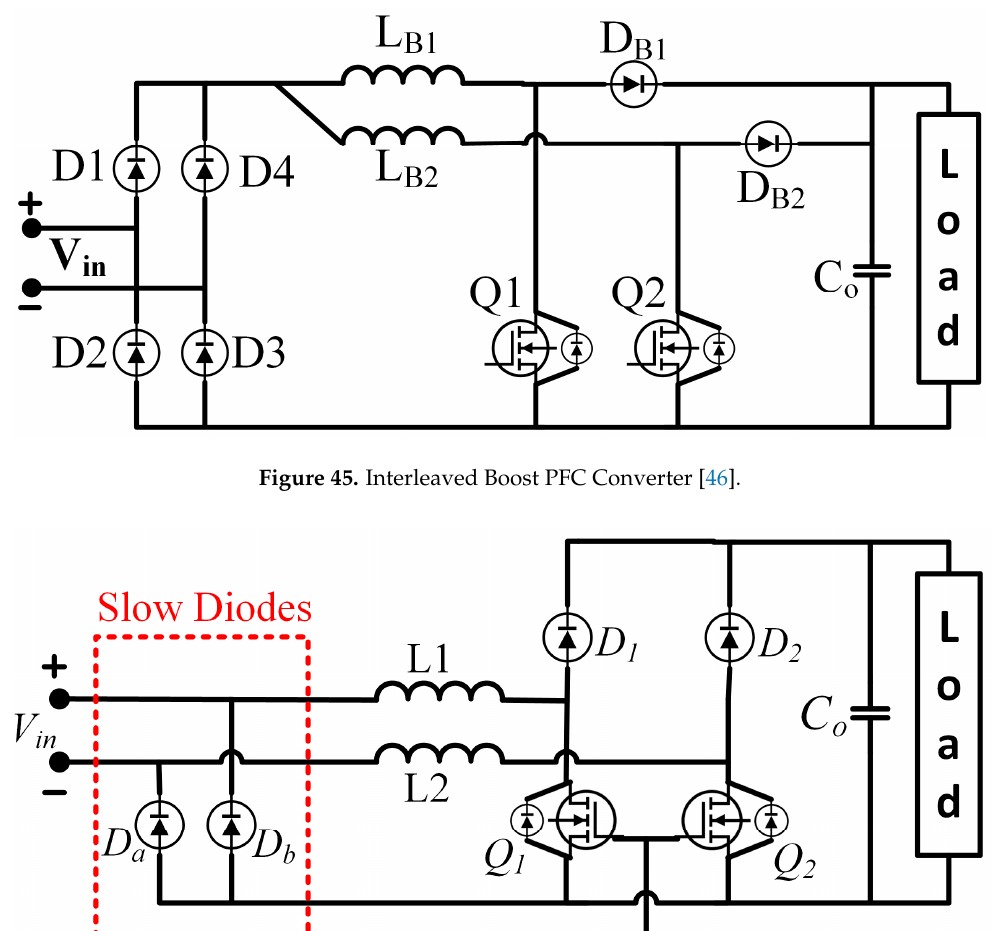
Figure 47. Bridgeless Interleaved Boost PFC Converter [46]. Williamson et al., presented some isolated DC-DC converter topologies in [44]. The ZVS FB Converter with Capacitive Output Filter (Figure 48) can achieve high efficiency as it uses zero voltage switching (ZVS) along with the capacitive output filters which reduces the ringing of diode rectifiers. The trailing edge PWM full-bridge system proposed in [107]. The Interleaved ZVS FB Converter with